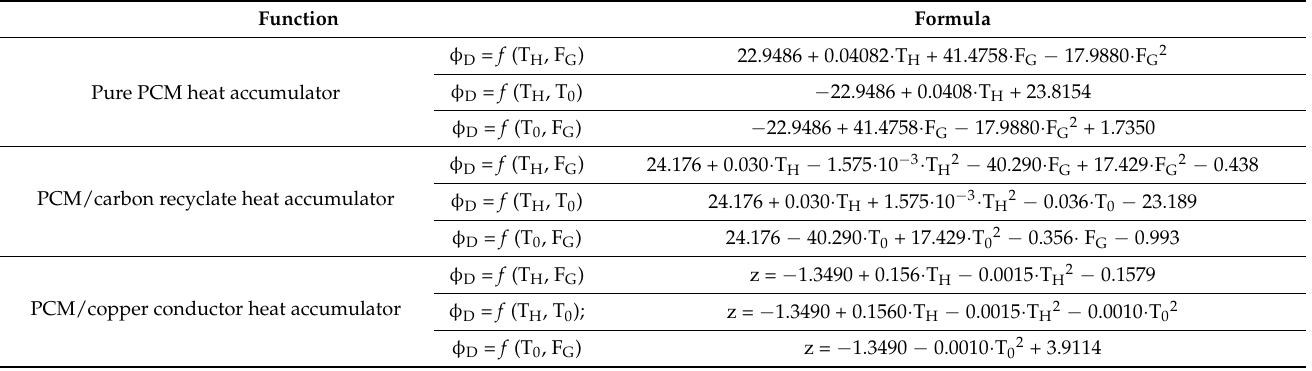
Table 8. List of the obtained approximating functions of the heat batteries examined.